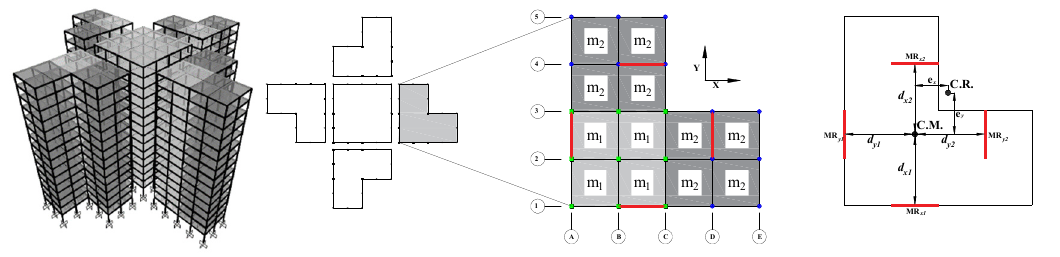
Figure 3. The idealized model of the soil–structure system.